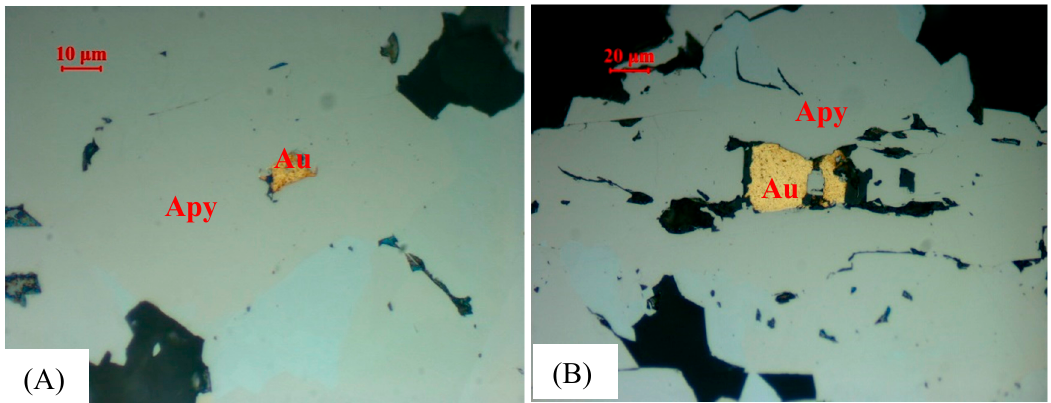
Figure 4. Images of gold in pyrite in reflected light: ( A ) enclosing gold in arsenopyrite; ( B ) hole gold in arsenopyrite (Apy—arsenopyrite; Au—gold).